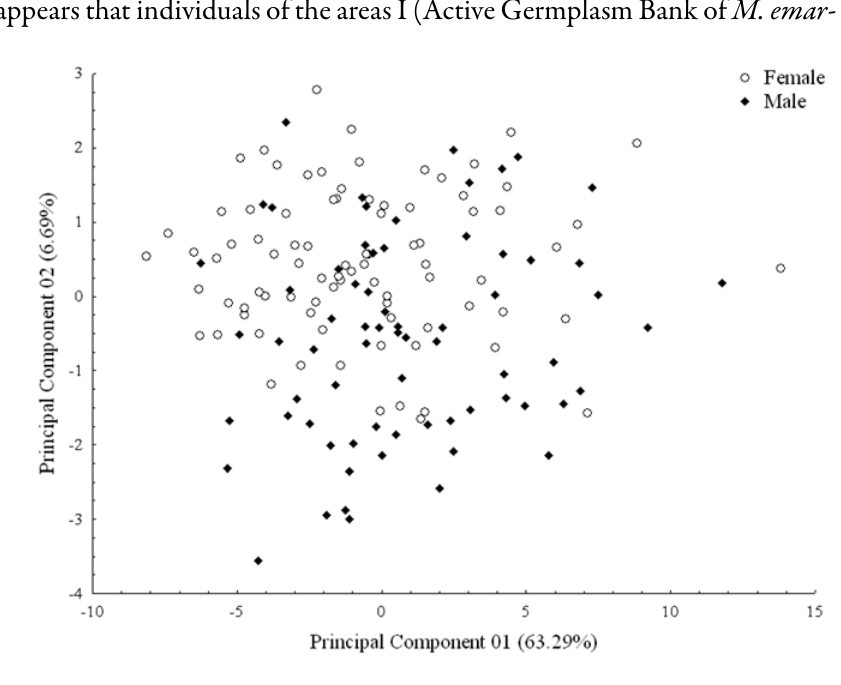
Fig. 4 - Graphic dispersion between males and females Tetrapedia diversipes in relation to Cartesian axes established by the first two principal components (PC1,